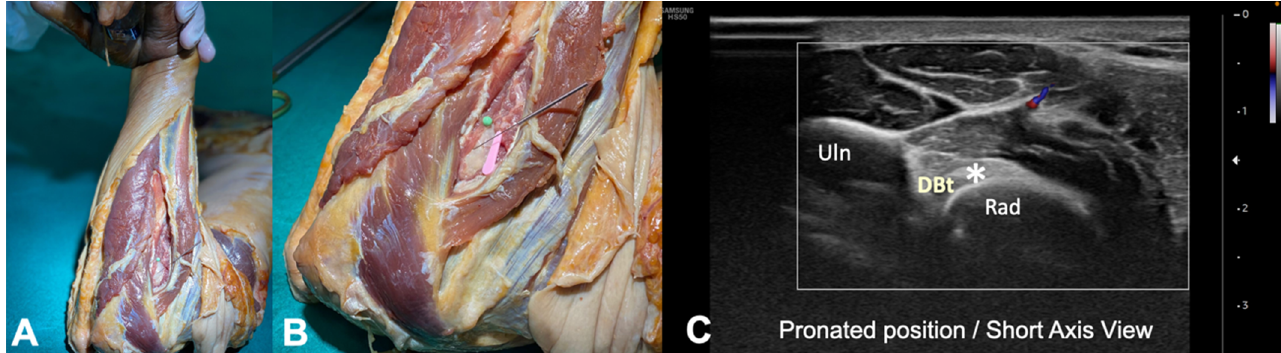
Figure 2. Anatomical schematic of the needle insertion with the elbow in flexion and the forearm in pronation “Cobra position”: ( A ) general view; ( B ) detailed view (tendon insertion-green pin). ( C ) US imaging of the short axis view (pronated position). The tendon insertion (hyperechoic) is observed on the radius tuberosity; (DBt)-Distal Biceps Tendon (Asterisk), (Uln)-Ulna, (Rad)-Radius). No important vascular or nervous structure was visualized (Color Power Doppler image).